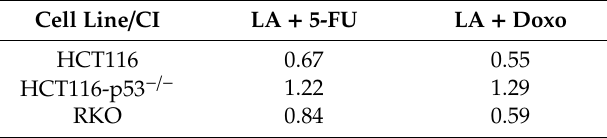
Table 2. Combination indexes (CI) determined by ATP assays and the Chou–Talalay-method Cell Line / CI LA +